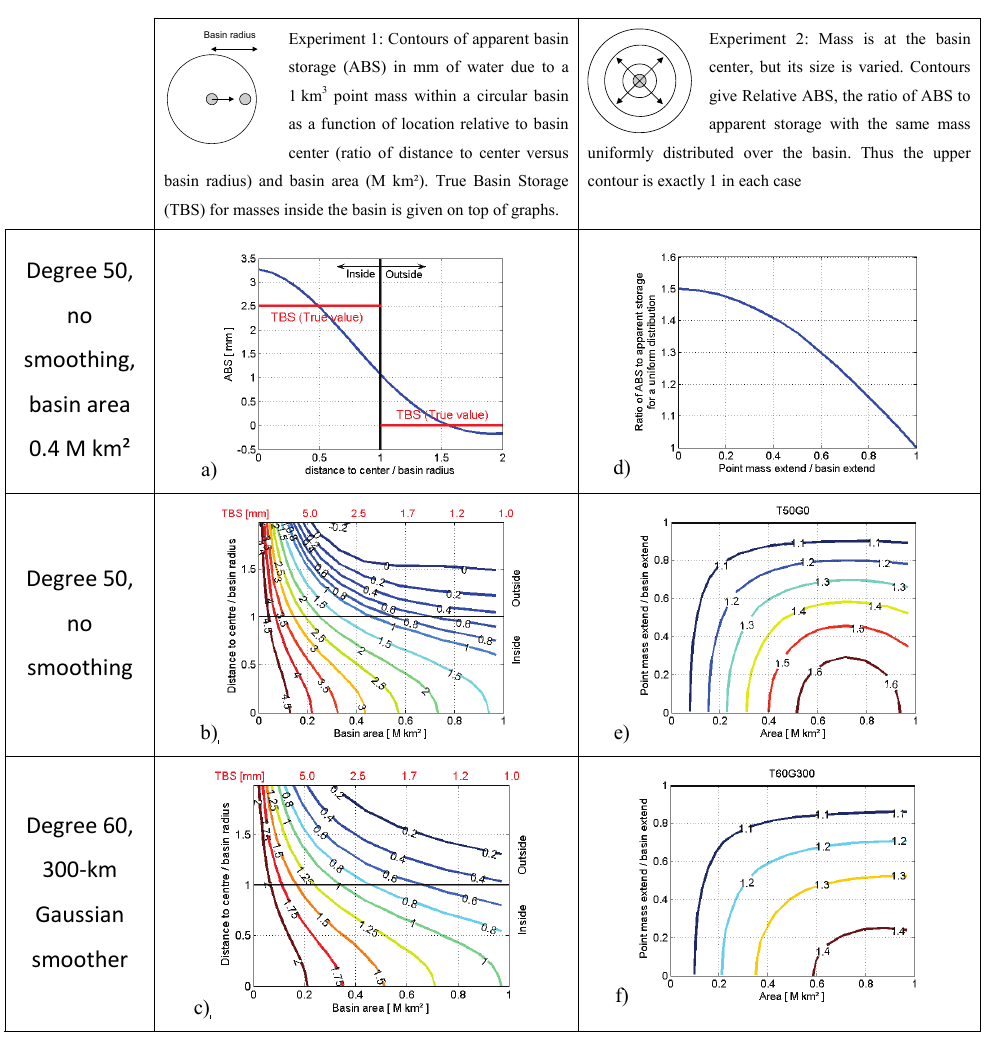
Fig. 2. Numerical experiment of the impact of a 1km 3 point mass to basin-wide estimates of water storage. In terms of GRACE processing, degree 50 no smoothing generally corresponds to processing applied to GRGS data and degree 60 plus 300km Gaussian smoothing generally corresponds to processing applied to CSR data. (a) Shows a contour of apparent basin storage (ABS) with varying location of the point mass from the basin center to outside the basin. True basin storage (TBS) is 2.5mm (1km 3 0.4Mkm − 2 ). (b) Shows contours of ABS in mm for varying basin areas (horizontal axis) and increasing distance of the mass from the basin center (vertical axis). (d) , (e) and (f) Show contours of ABS divided by the same impact (apparent storage) when the mass is distributed uniformly for varying basin areas (horizontal axis) and decreasing concentration (vertical axis). Refer to supplementary information S1 and S2 for more case studies and additional